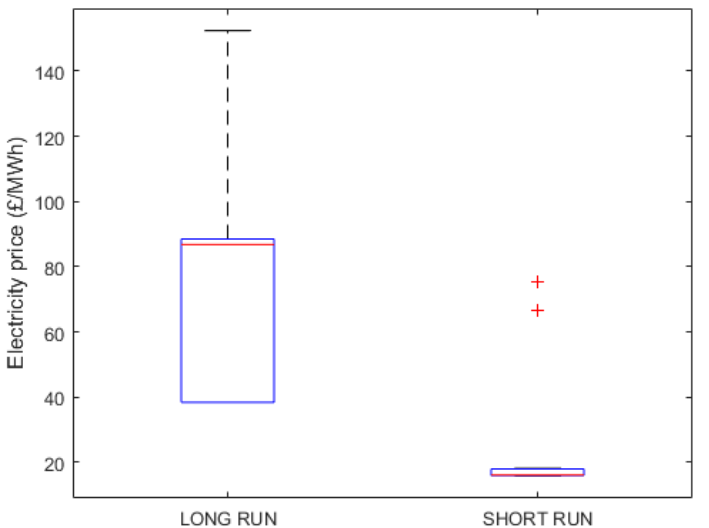
Figure 3. Comparison of electricity price distribution. (The top and bottom edges of the blue box are the third and first quartiles of the distribution. The distance between them is the Inter-Quartile Range (IQR). The red line inside the box is the median. The red crosses are outliers, they are points that are either more than 3 × IQR above the third quartile or 3 × IQR below the first quartile. The horizontal black lines are the maximum and minimum values within the 3 × IQR distance specified above.).